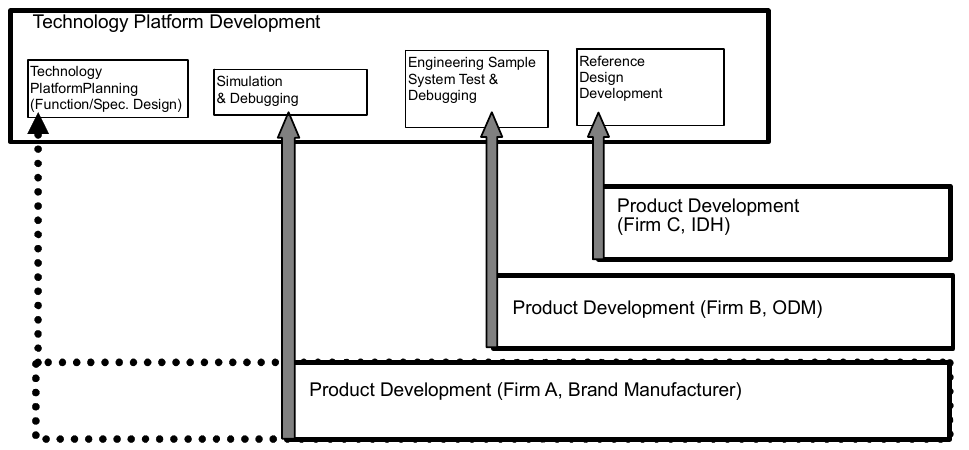
Figure 5. Differences in collaboration object and timing in Japan, Taiwan, and